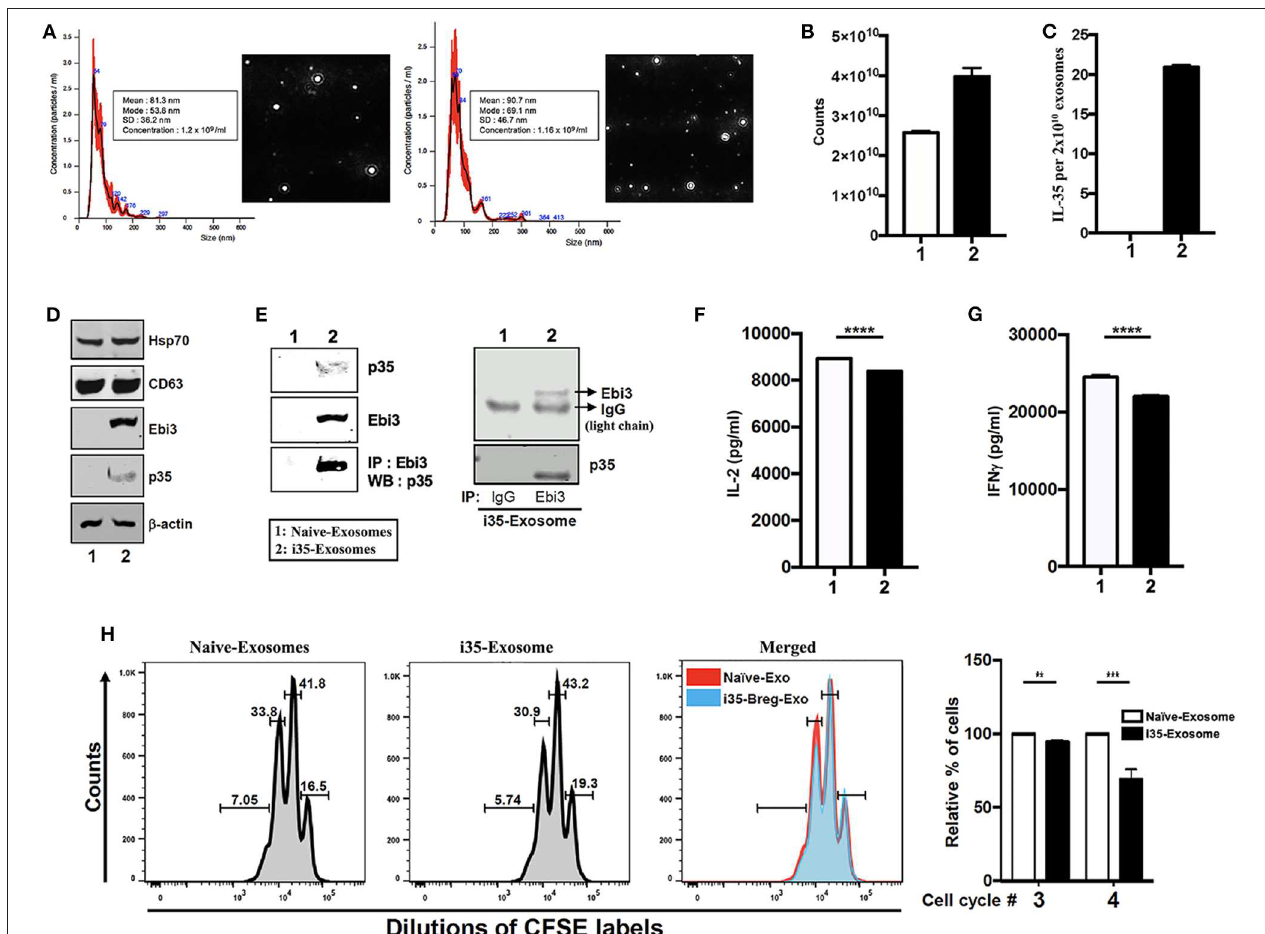
FIGURE 1 | Breg cells release exosomes that contain the immune suppressive IL-35 cytokine. (A) Purification, characterization, and quantification of exosomes derived from activated B cells that do not produce IL-35 (Naïve-Exosomes) or IL-35-secreting regulatory B cells (i35-Exosomes). Size distribution analysis of exosome samples analyzed by Nanoparticle Tracking Analysis (NTA). Mean ± SEM of three independent experiments is shown. (B,C) Quantified of exosome released in unstimulated and stimulated B cell cultures by use of the Exosome Quantitation Assay (B) and determination of amounts of IL-35 contained in 2 × 10 10 Naïve-Exosomes or i35-Exosomes ( n = 6 ) by ELISA (C) . (D) Western blot analysis of exosomal markers (HSP70 and CD63) expressed by exosomes derived from i35-Breg cells (right) or exosomes from B cells that do not produce IL-35 (Naive-Exosomes, left). (E) Lysates derived from Naïve-Exosomes or i35-Exosomes were